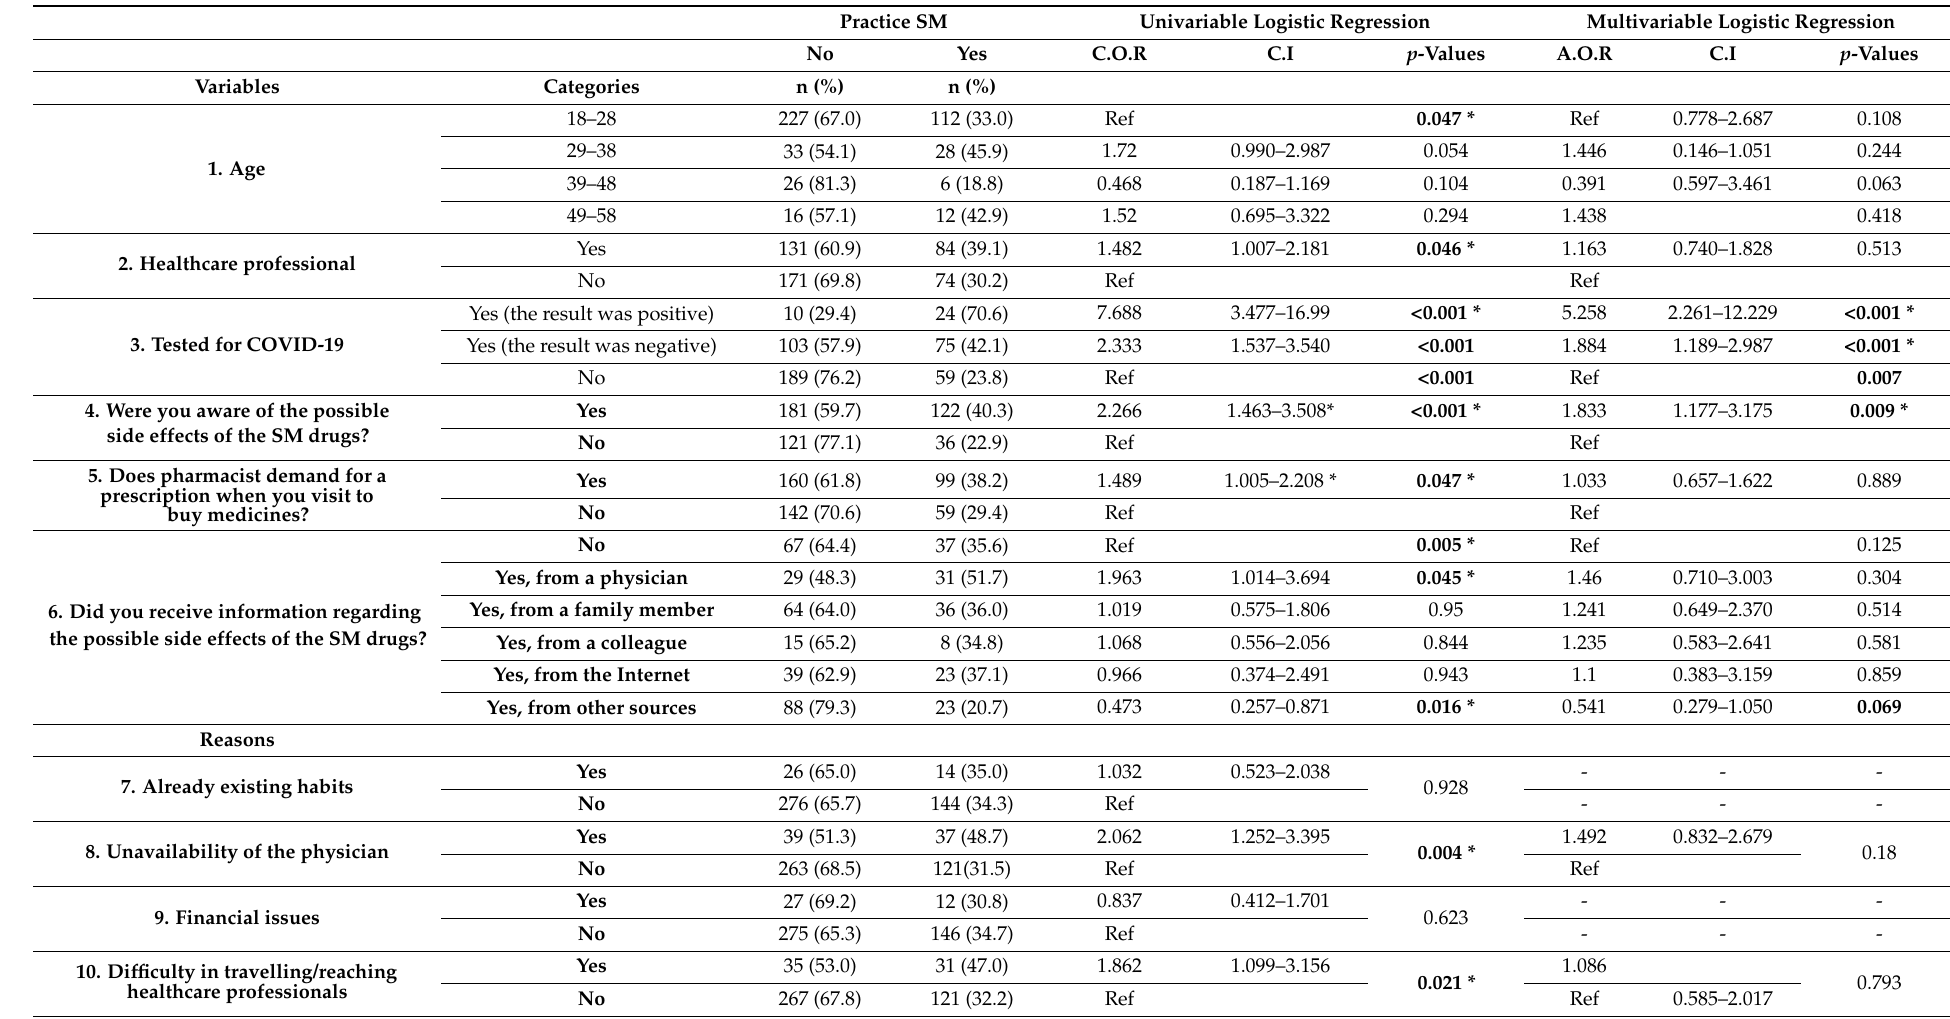
Table 5. Logistic regression analysis for identification of contributing factors for SM during